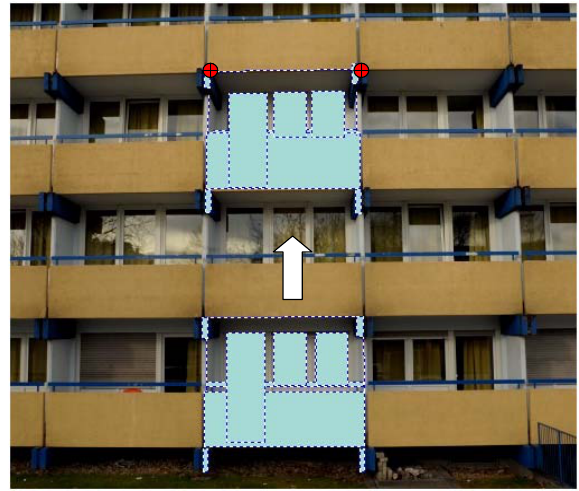
Figure 2: Facade mapping taking benefit of repeating features, fitted with anchor points.